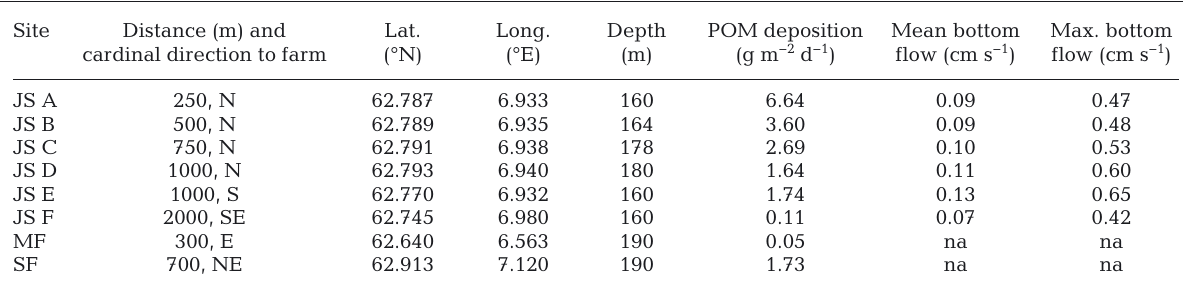
Table 1. Distance and cardinal direction from the closest fish farm to the collected corals as well as geographical position, depth, modelled sedimentation rate of particulate organic matter (POM) and mean and maximum bottom current speed (from the NorFjords160 model). JS: Julsundet; MF: Midtfjorden; SF: Sunndalsfjorden; na: not